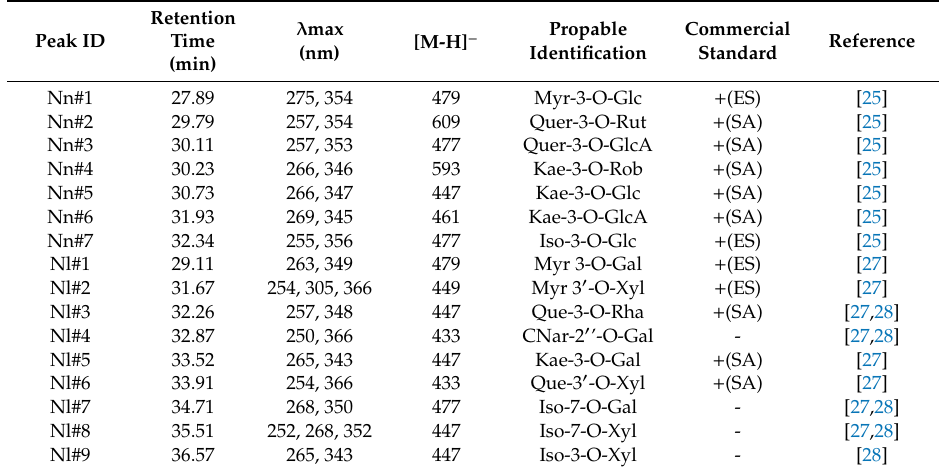
Table 2. Characteristic and probable identification of flavonoids from N. nucifera and N. lotus stamen extract.